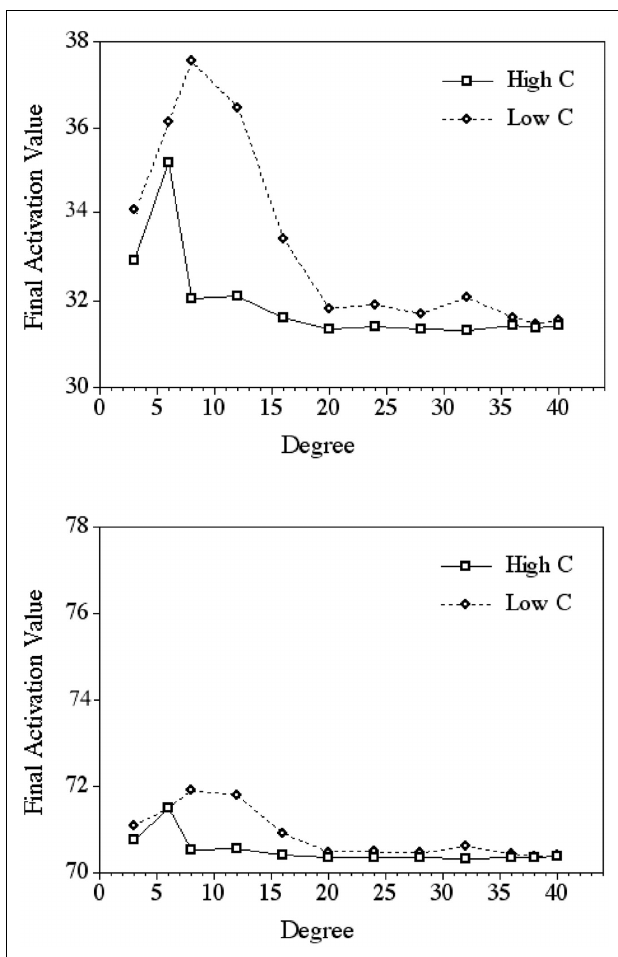
FIGURE 3 | Final activation values in the target nodes after 10 time steps as a function of C and degree. The top panel shows the results of the simulation when (the proportion of activation retained at a node) r = 0.3, and the bottom panel shows the results when r = 0.7.These results are illustrative of other values of r . For instances in which the markers appear on top of one another the difference in activation value between high and low C was observed in the tenth, or hundredth